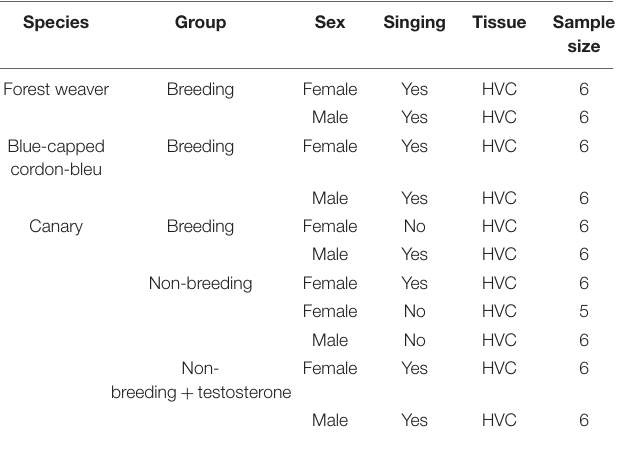
TABLE 1 | Experimental groups and sample